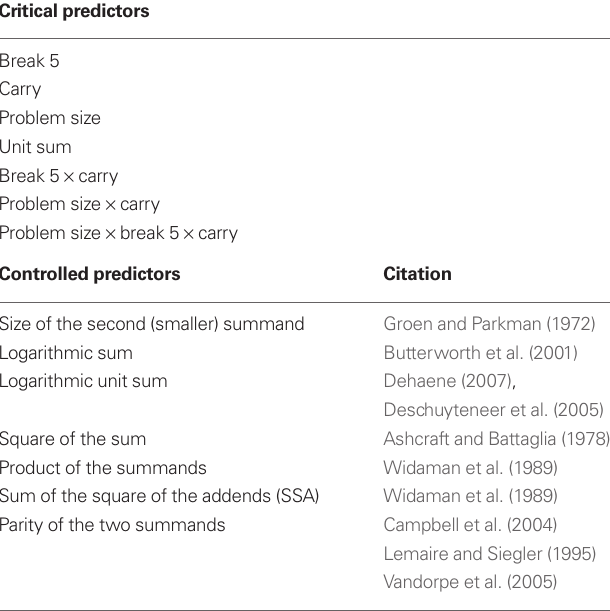
Table 1 | Critical predictors (necessary for testing our hypotheses) and controlled predictors (motivated by the literature on mental addition and included to substantiate the results) included in the stepwise multiple regression